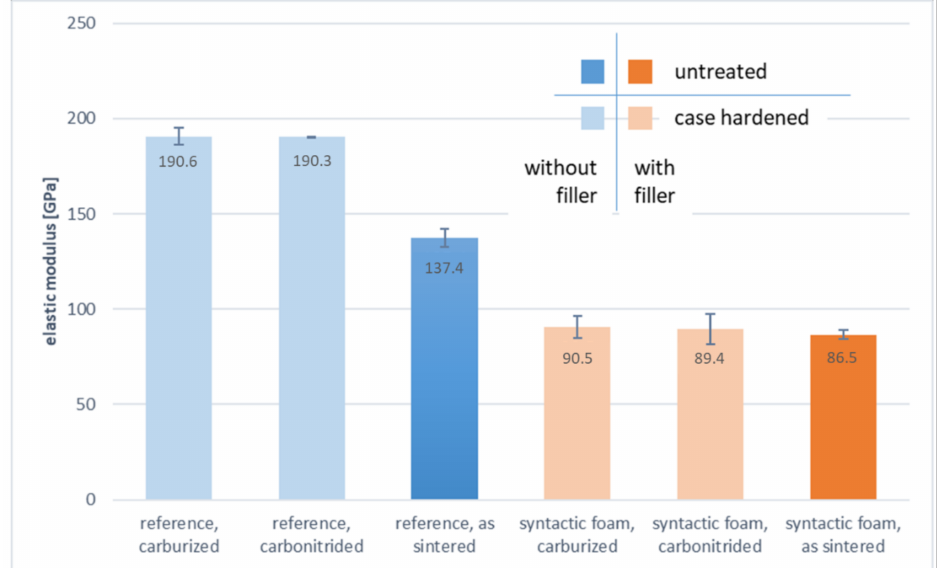
Figure 14. Comparison of the approximate elastic (bending) modulus of the various types of samples with/without heat treatment and with/without filler (with standard